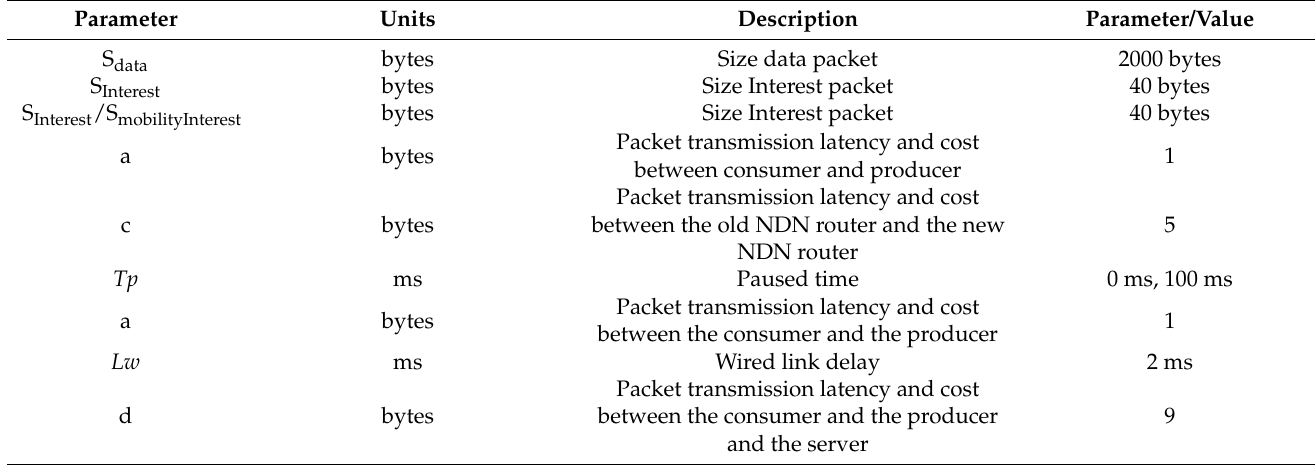
Table 6. Network analysis parameter